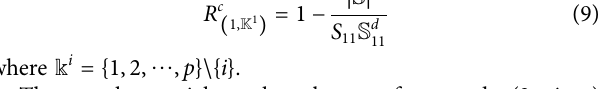
TABLE 1 | Data sources and variable de fi